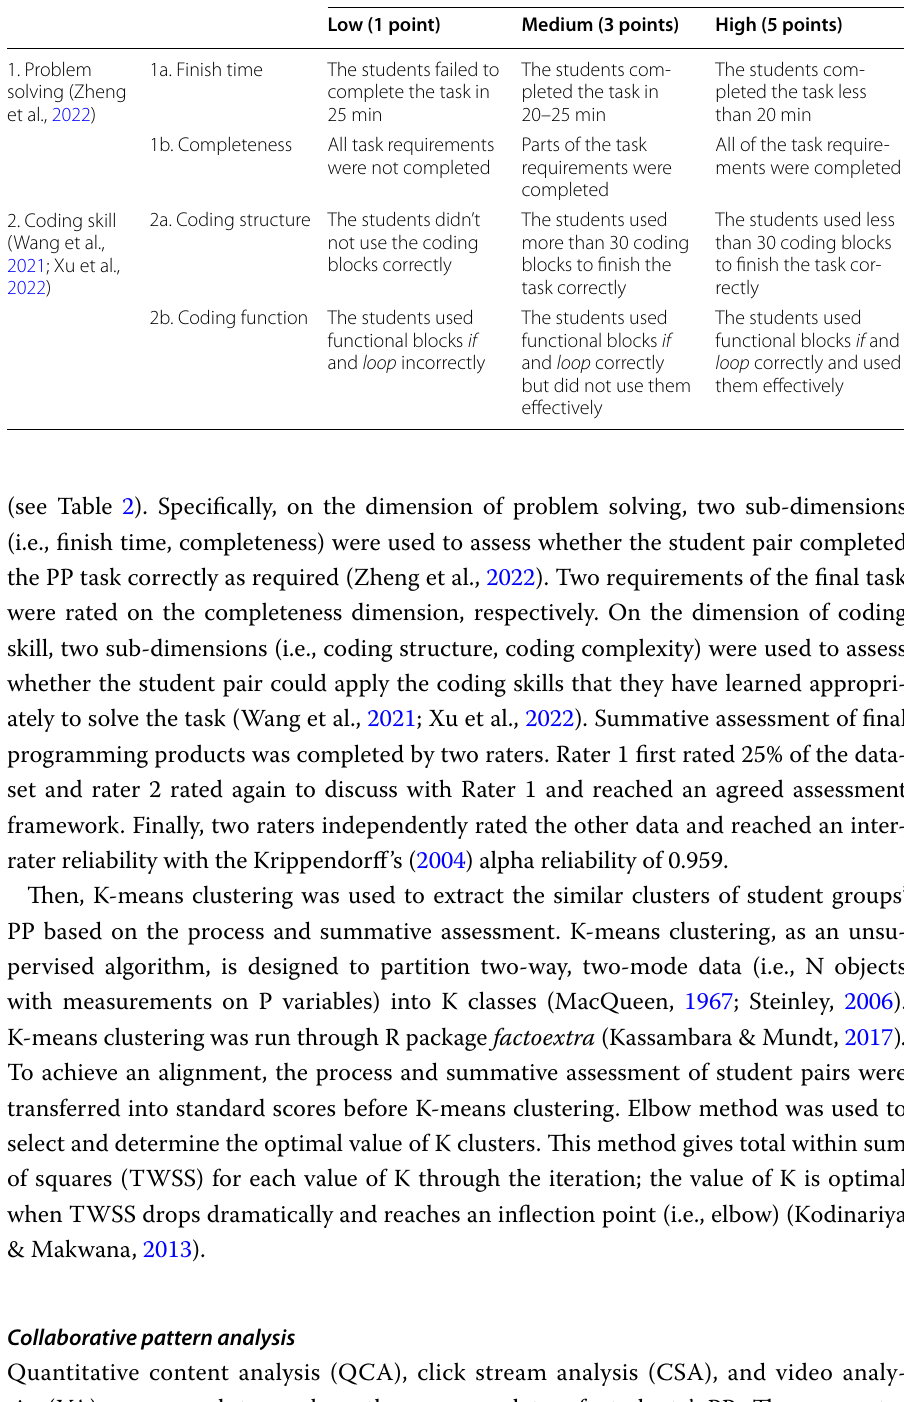
Table 2 The summative assessment framework of collaborative product